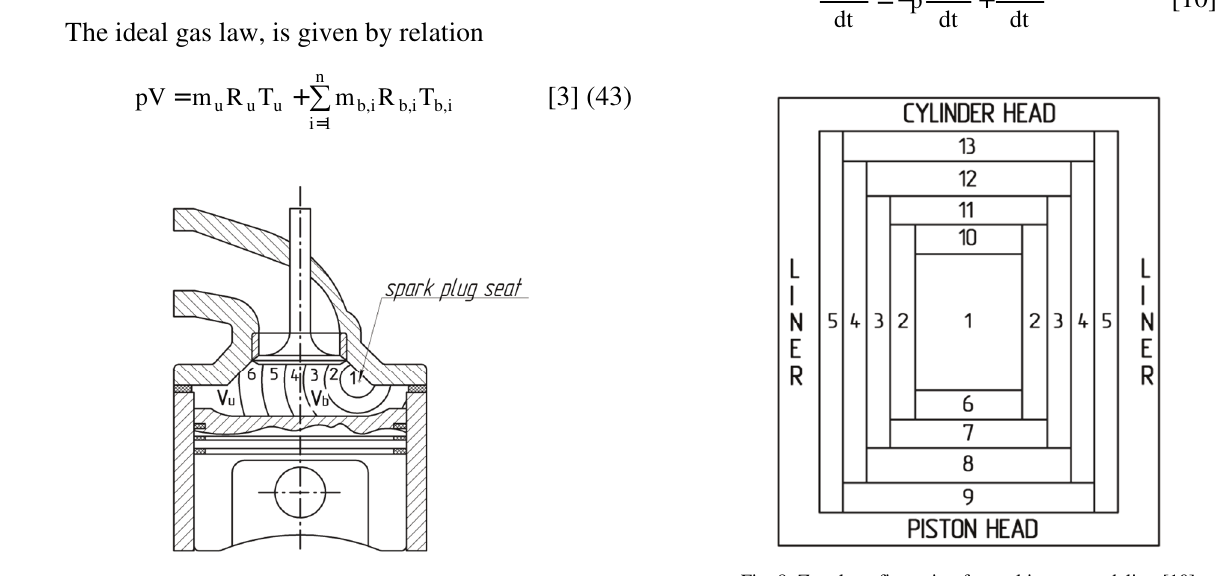
Fig. 7. Multi-zone division by Baratt [3] Fig. 8. Zonal configuration for multi-zone modeling [10]